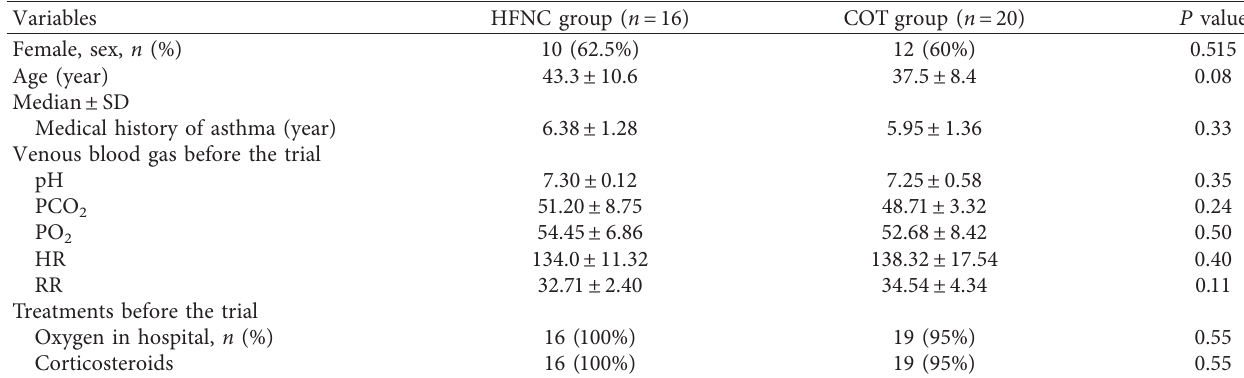
Table 2: Therapeutic effects of HFNC and COT in patients with severe asthma exacerbation combined with respiratory failure.